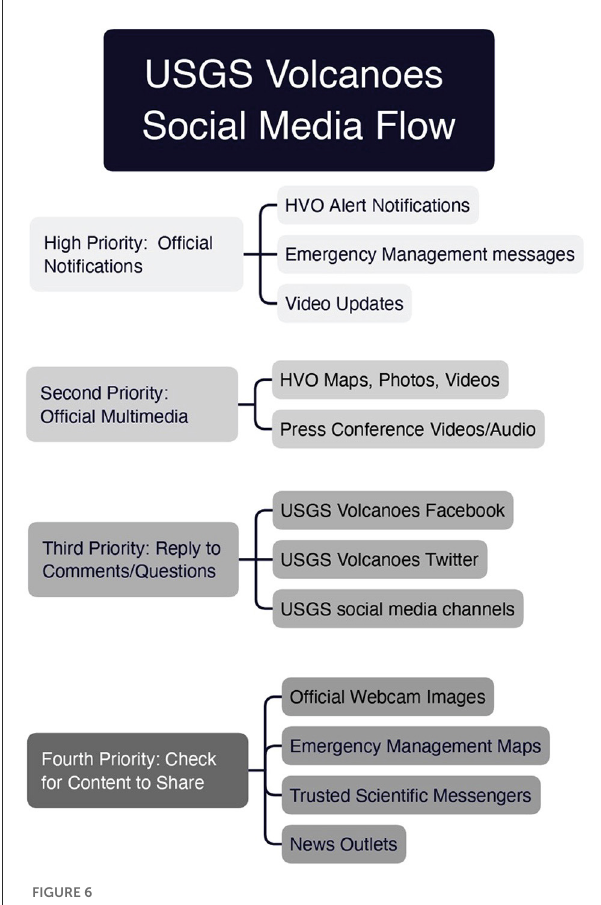
FIGURE6 Prioritized checklist of content types and information shared on USGS Volcanoes’ social media channels during the 2018 K¯ılauea eruption